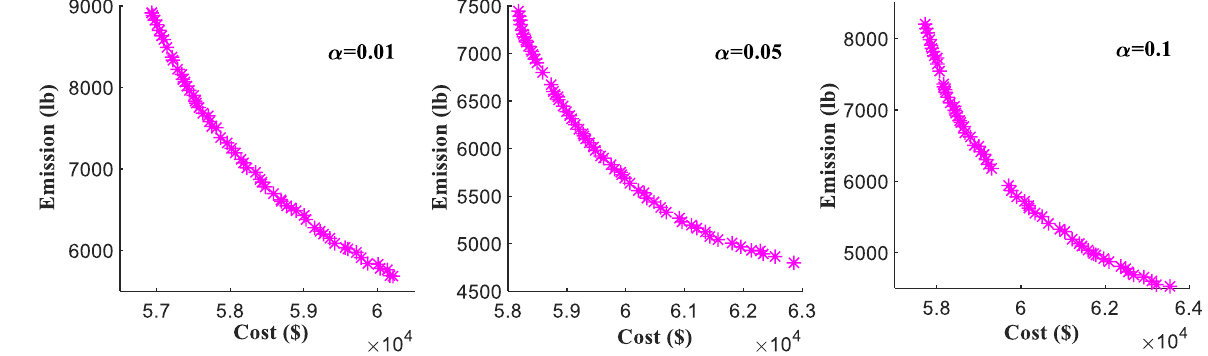
Figure 2. Pareto-optimal frontier under different reliability levels.